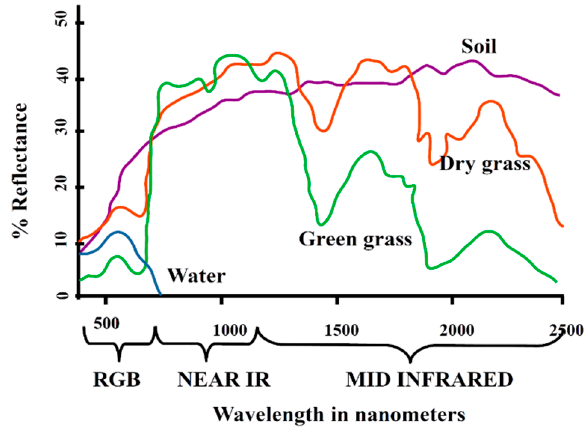
Figure 2. The electromagnetic reflectance from the Earth’s surface of different elements [16].